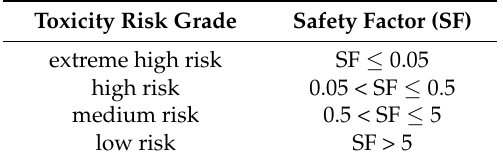
Table 1. Definition of the pesticide risk grades to insects.